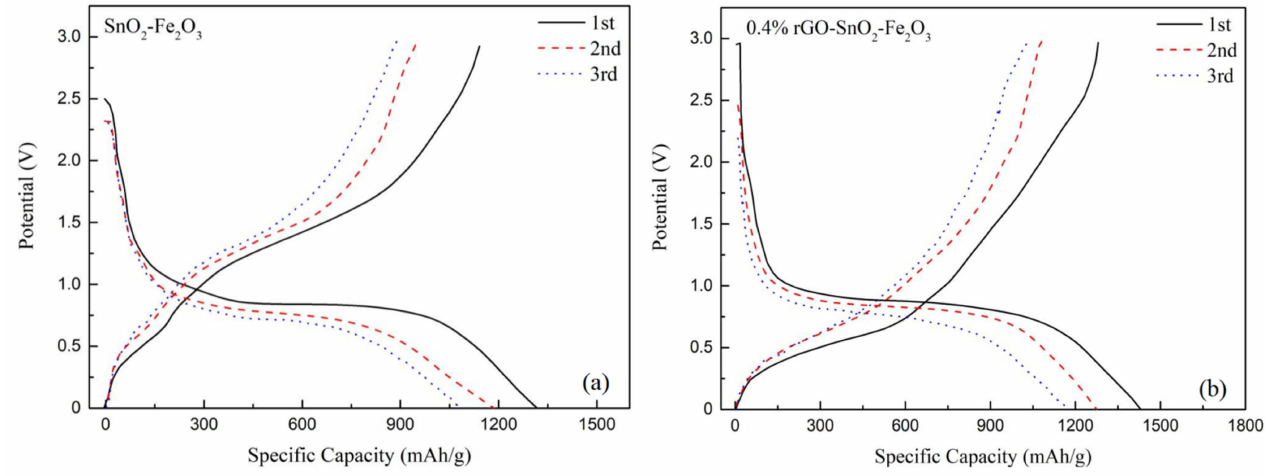
Figure 5. The first three-time capacity-voltage curves. ( a ) 10%SnO 2 -Fe 2 O 3 ; ( b ) 0.4%rGO-10%SnO 2 - Fe 2 O 3